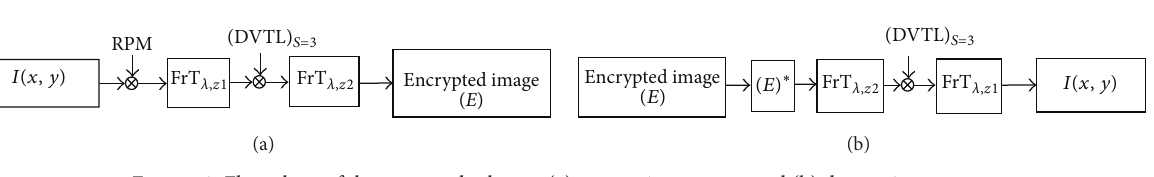
Figure 2: Flow chart of the proposed scheme: (a) encryption process and (b) decryption process.